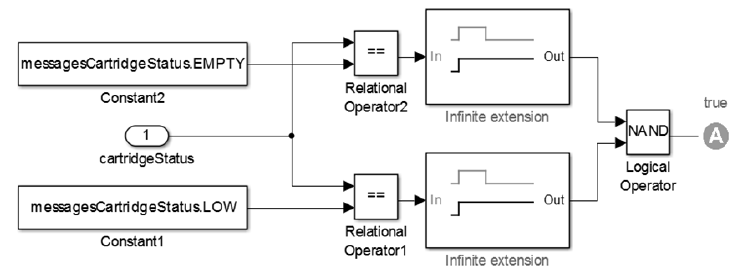
Figure 30. Assumption About the Cartridge’s